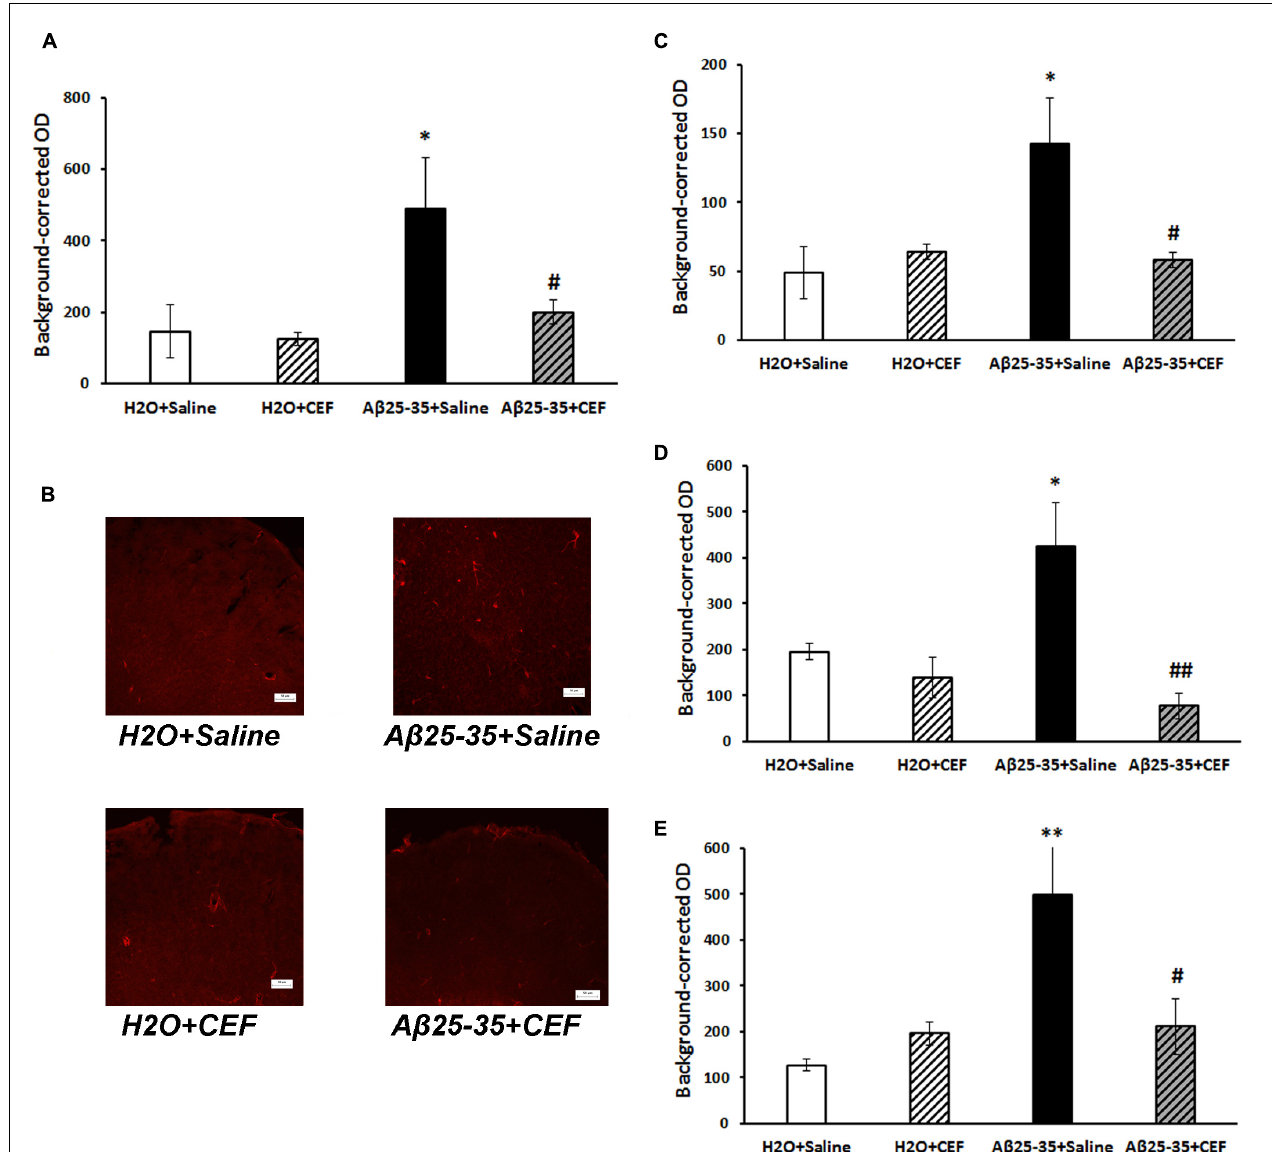
FIGURE 5 | Effects of the CEF and A β 25–35 administration (AD model) on the expression of inflammatory marker CD54 in the frontal cortex (A,B) or hippocampus ( C in the CA1 area; D in the CA3 area; E in the dentate gyrus) in mice. (A,C–E) Quantitative results. The data are expressed as mean ± SEM of the values obtained in an independent group of animals ( n = 3–4 per group). Statistically significant differences: ∗ p < 0.05, ∗∗ p < 0.01 vs. the “H 2 O + saline” group; # p < 0.05, ## p < 0.01 vs. the “A β + saline” group. (B) CD54 immunoreactivity in the frontal cortex. Magnification, × 200; bar, 50 µ